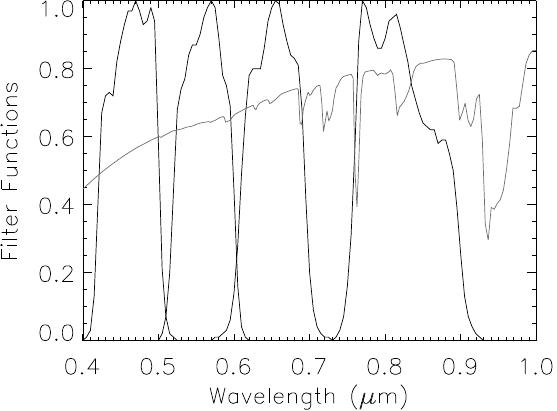
Figure 1. AVNIR-2 channel filter curves and atmospheric